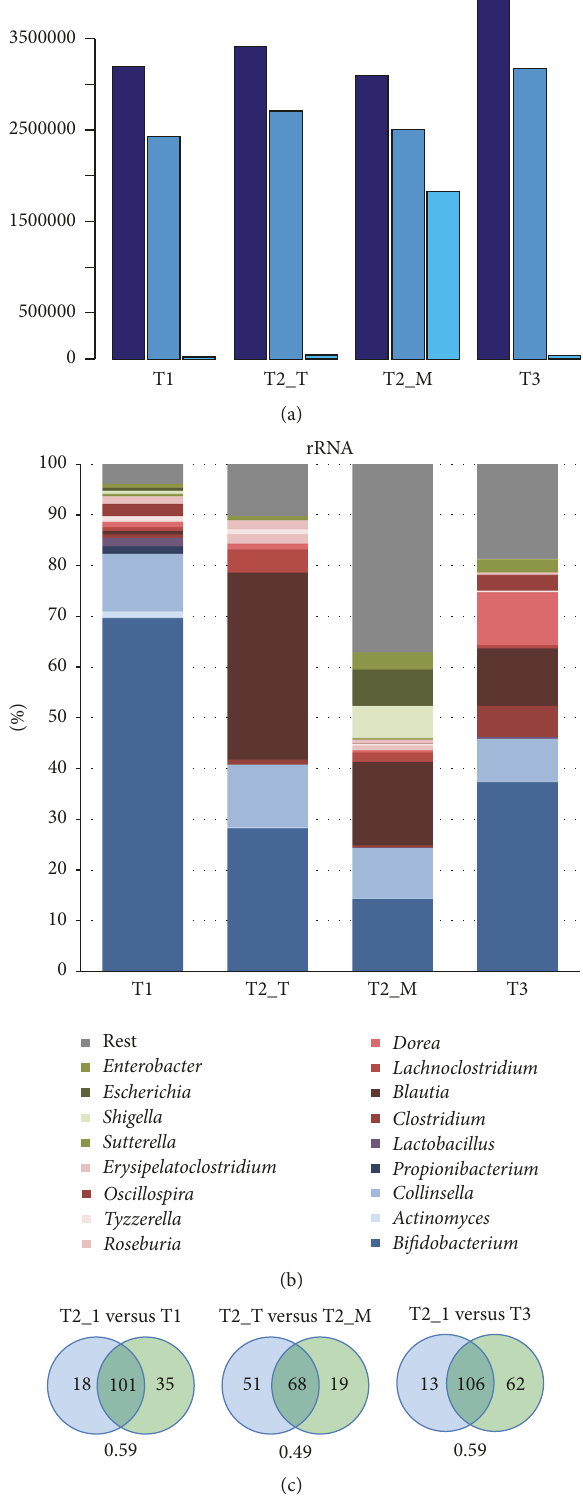
Figure1:(a)Numbersofreadsatdifferentstagesofinsilicofiltering. Raw reads (dark blue), after quality filtering (medium blue) and after quality and rRNA filtering (light blue). (b) Taxonomic profiles basedon16SrRNA.(c)NumbersofsharedgenerabetweenT2 Tand other samples. The Jaccard index below the Venn diagrams shows the relationship between shared and all